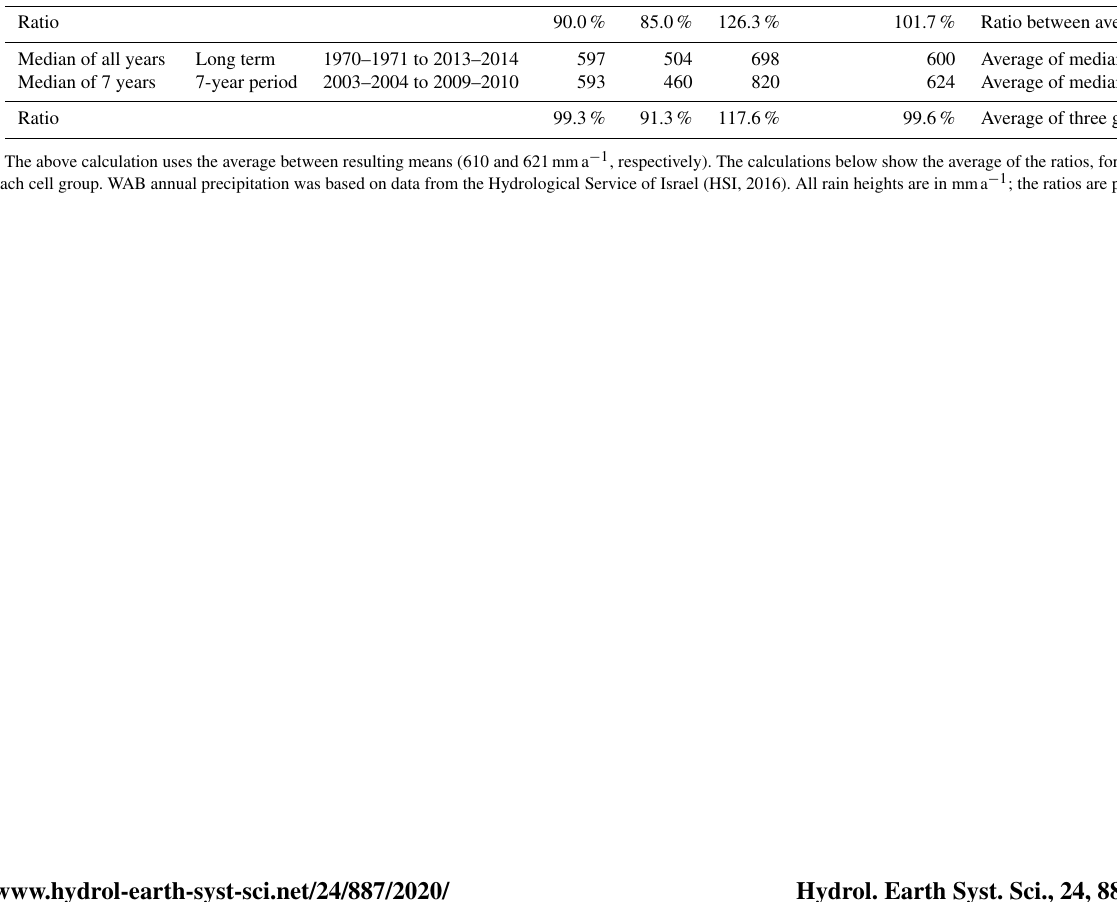
Table E1. Comparison of average rainfall in WAB cell groups: long term and the seven years from 2003–2004 to 2009–2010. Cell No. 210